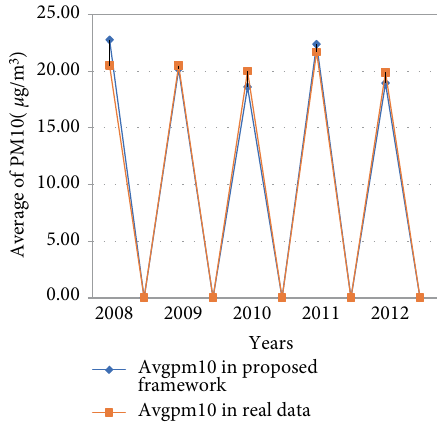
Figure 12: The monthly average air quality index for PM10 over London from 2008 to